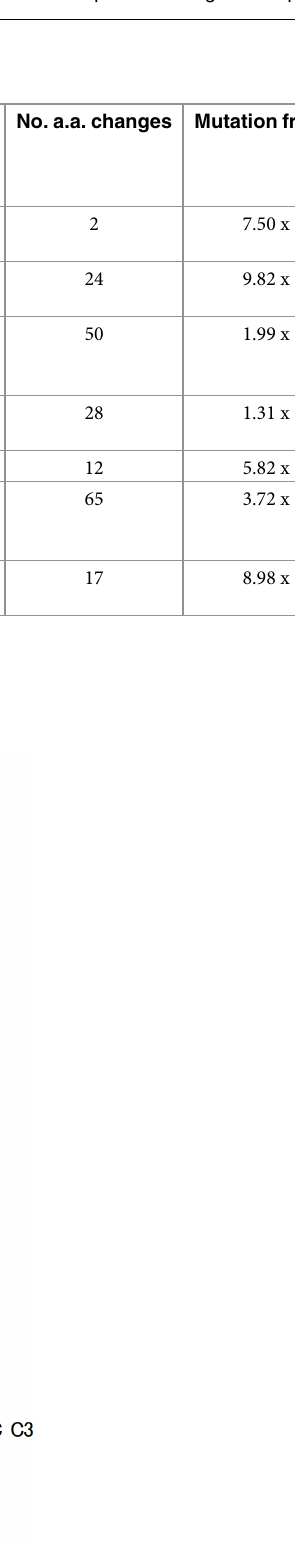
Fig 4. Phylogenetic relationships between the envelope (E) protein genes of members of the initial stocks of wild type (WT) and infectious clone (IC) derived DENV 1. The bar represents the number of nucleotide substitutions per